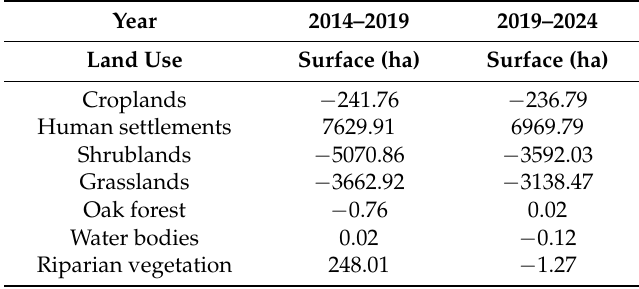
Table 10. Dynamics of land use changes for seven land use types of the urban and peripheral areas of Chihuahua City by 2019 and 2024 .